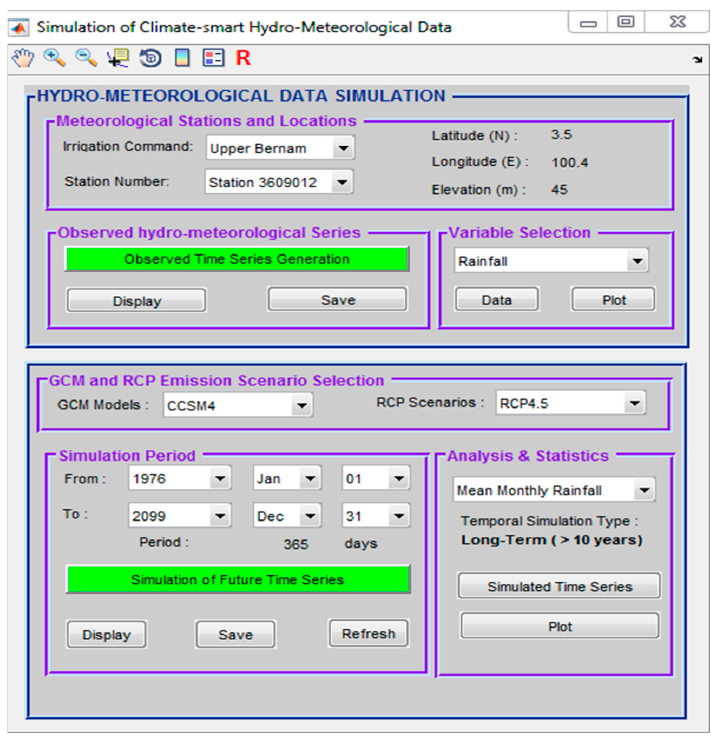
Figure 5. Dialog main window of the hydro-meteorological interface for the simulation of climate data in the Bernam River catchment area.